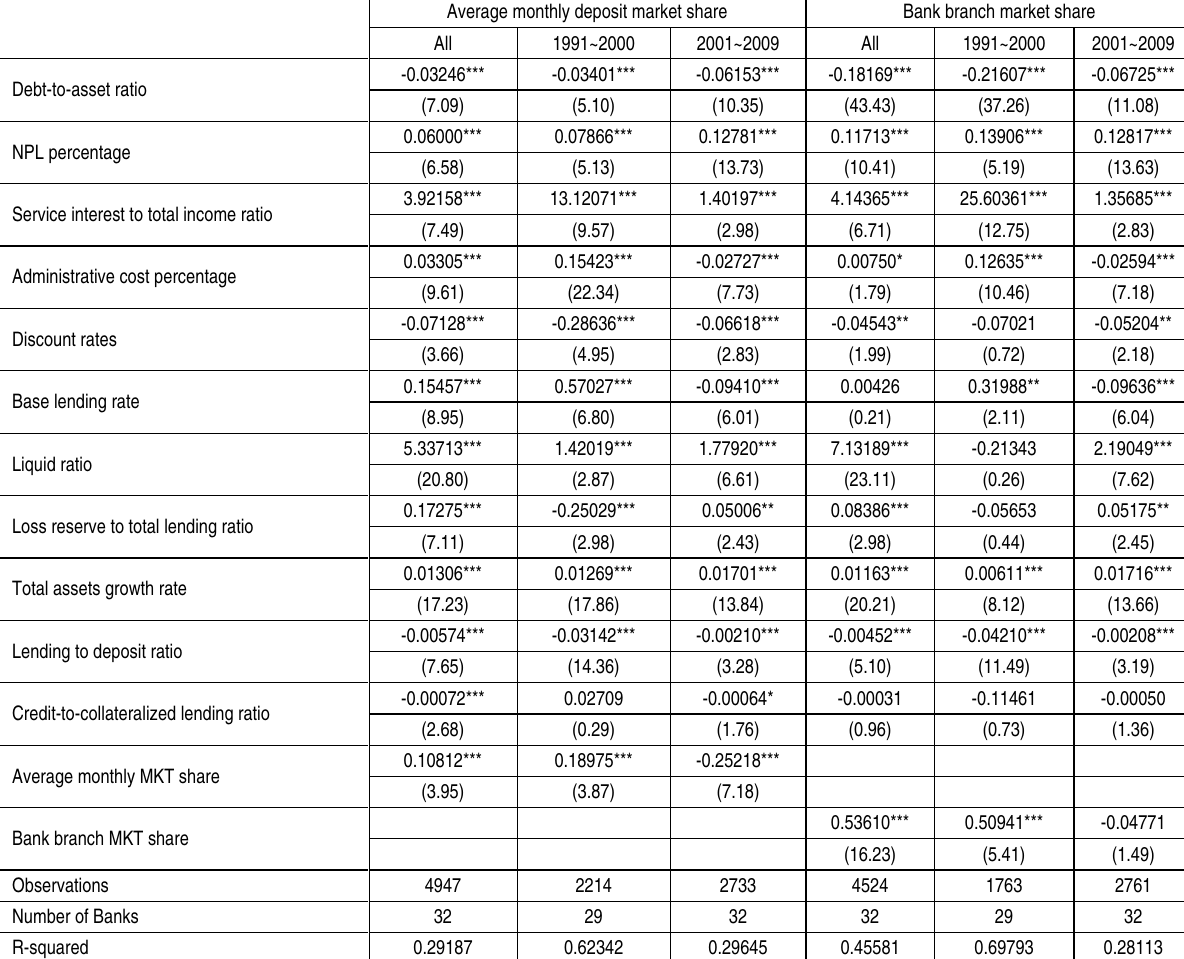
Fig. 1. Credit lending to total lending: historical percentage Table 3 adds several more control variables. With regression model includes the variables from the these additional variables, samples and sub-sample base model and four other variables that are related panel regressions all have improved R-squares. This to a bank’s internal operation and lending practices. Table 3. Deposit and branch market shares – adding lending practice